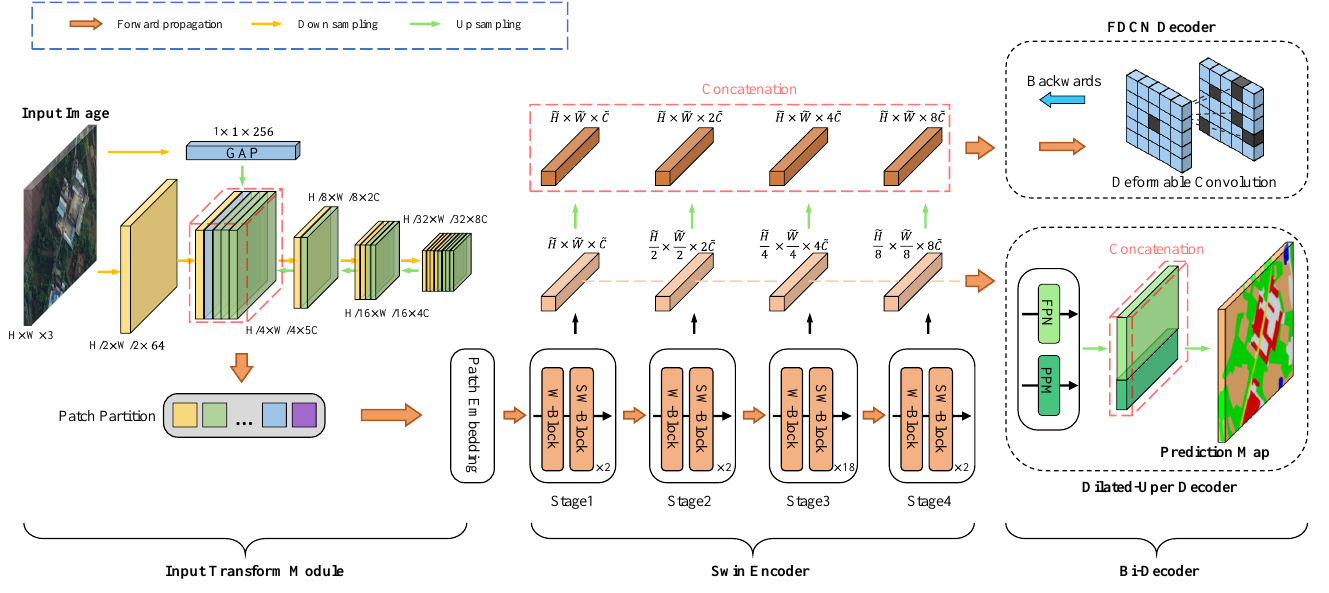
Figure 1. The overall architecture of the proposed BiTSRS. The architecture includes three main parts: an Input Transform Module (ITM) to transform large-scale inputs into small-scale feature maps, a Swin transformer encoder to acquire global and local representations, and a bi-decoder structure to decode coarse and fine information.